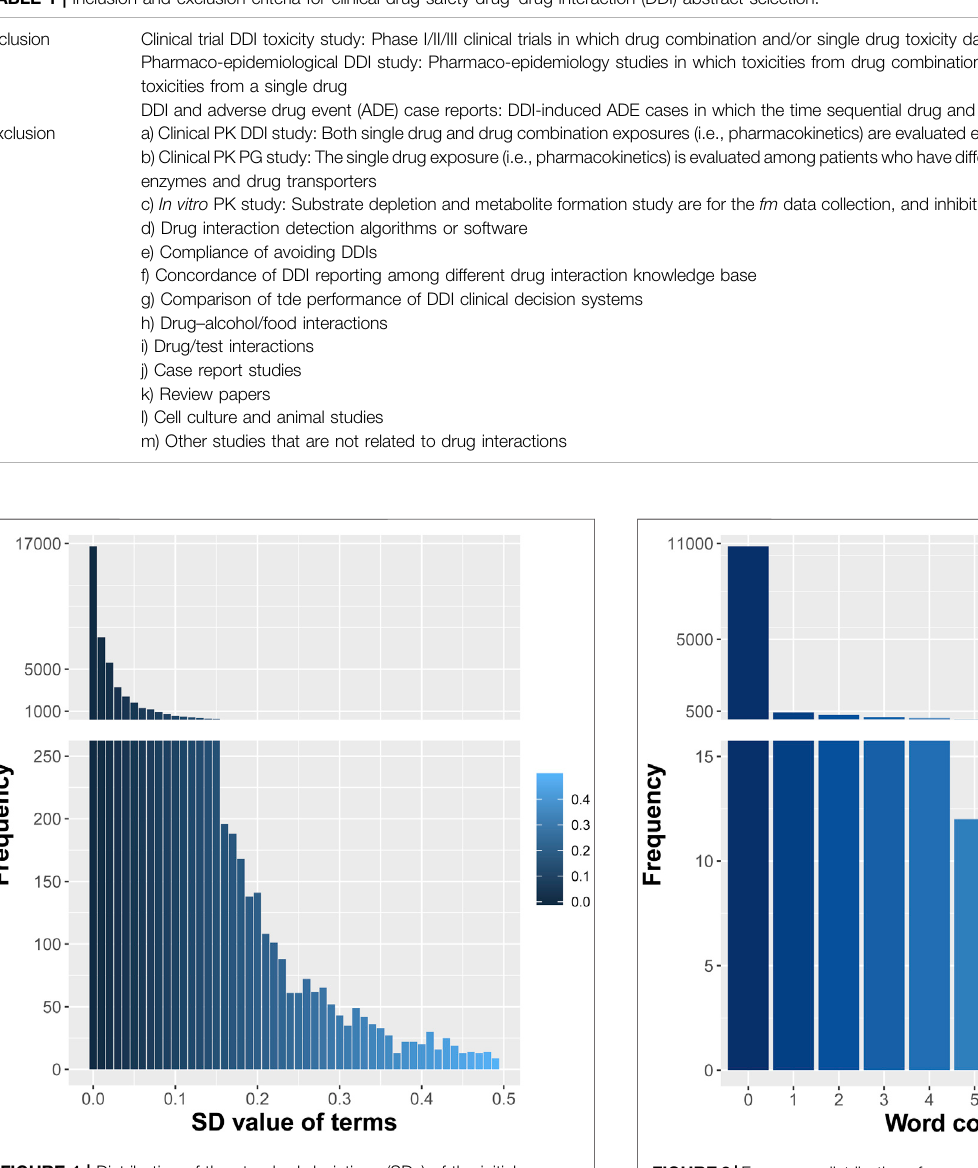
Frontiers in Pharmacology |